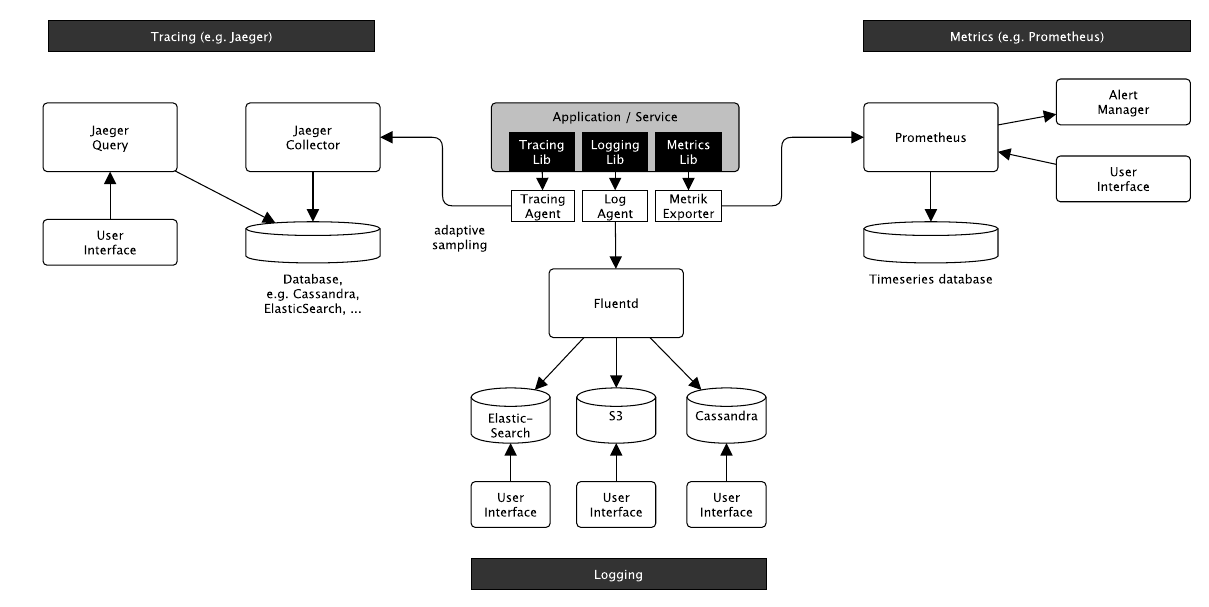
Figure 2. An application is quickly surrounded by a complex observability system when metrics, tracing, and logs are captured with different observability